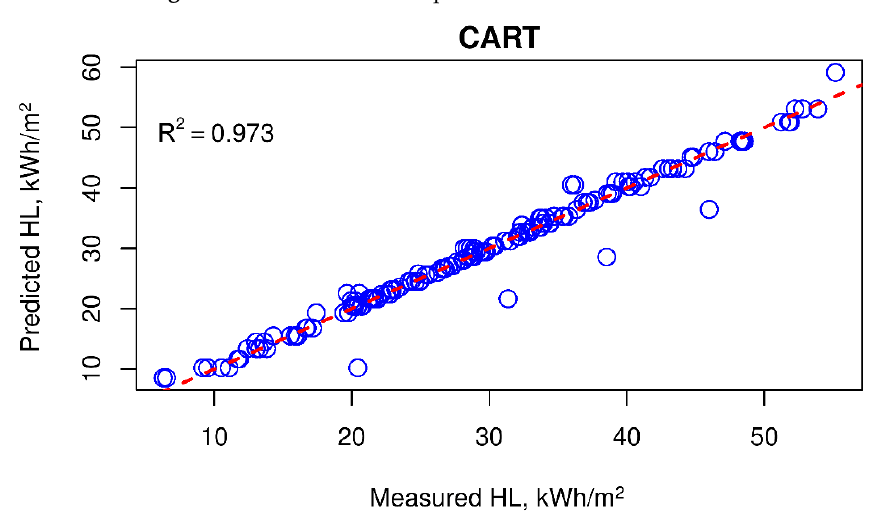
Figure 16. The results of HL prediction from the CART model.